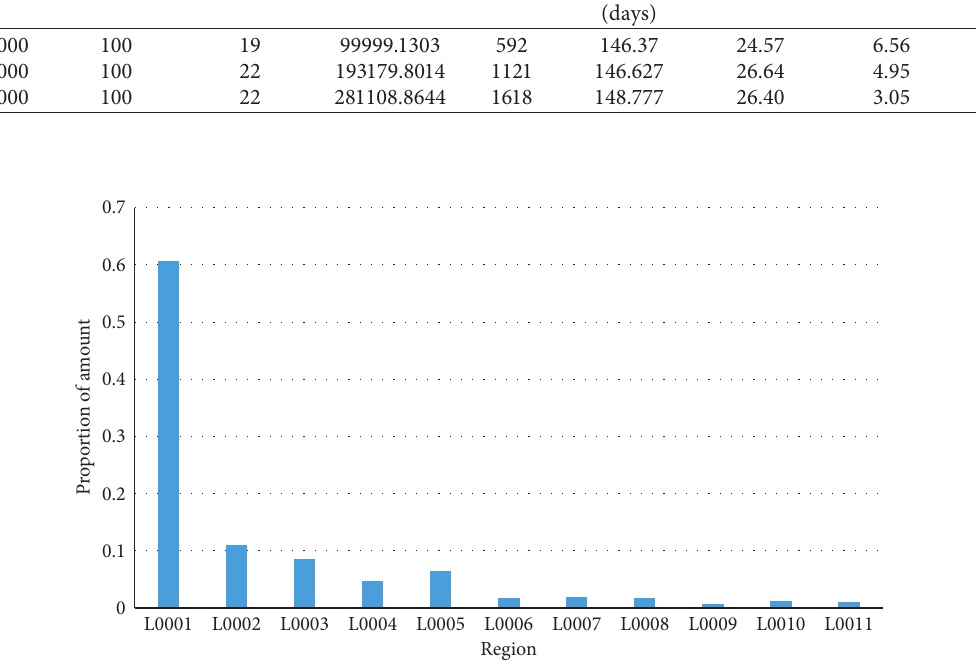
Figure 4: Distribution of assets among different